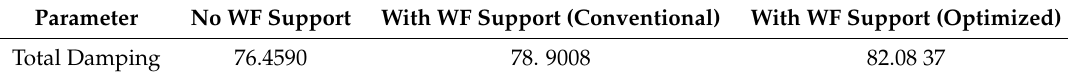
Table 3. Comparison of total